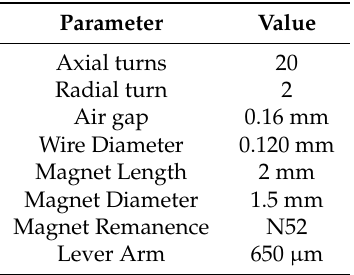
Figure 4. The force profile of the electromagnetic actuator. Table 2. Zou et al.